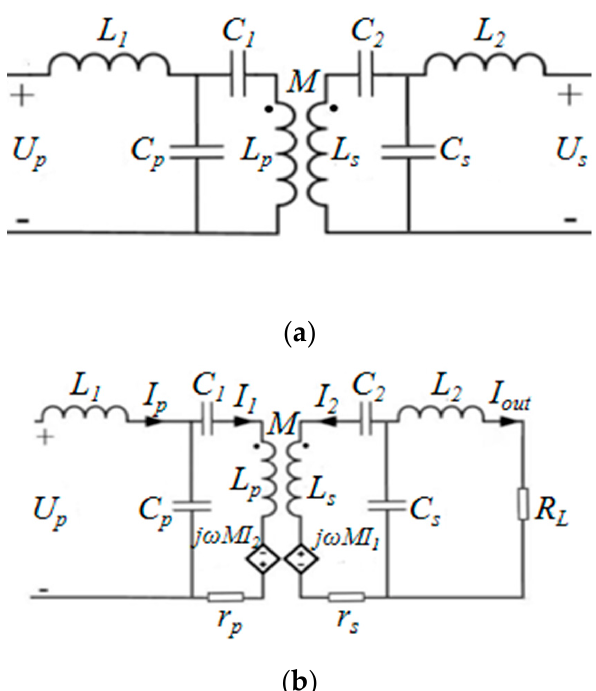
Figure 13. Dual-LCC compensation model and equivalent circuit: ( a ) dual-LCC compensation model, ( b ) dual-LCC equivalent circuit.